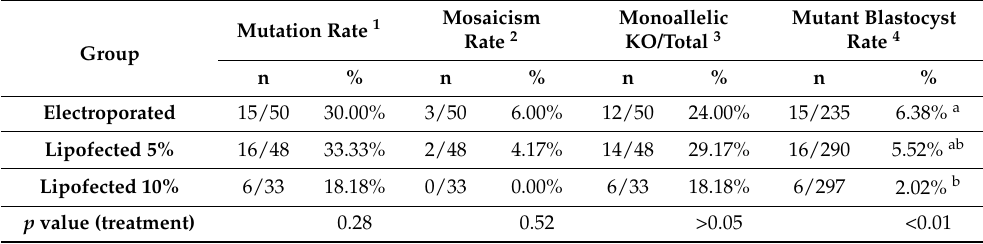
Table 4. Mutation and mosaicism rates in pig embryos after electroporation or lipofection with the CRISPR/Cas9 system. Variables were analyzed via the non-parametrical Kruskal–Wallis test. When significant differences were detected ( p < 0.05), the values were compared via the Conover–Iman test for pairwise comparisons.